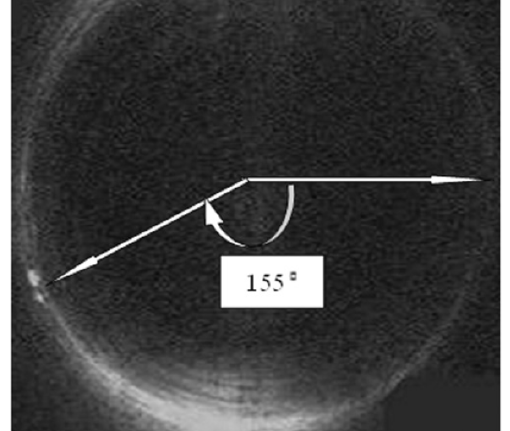
Figure 51. The ring profile of a pipeline segment showing the angular position of two ruptures. Reprinted from NDT & E E International, Volume 52, Safizadeh, M.S.; Azzizadeh, T.